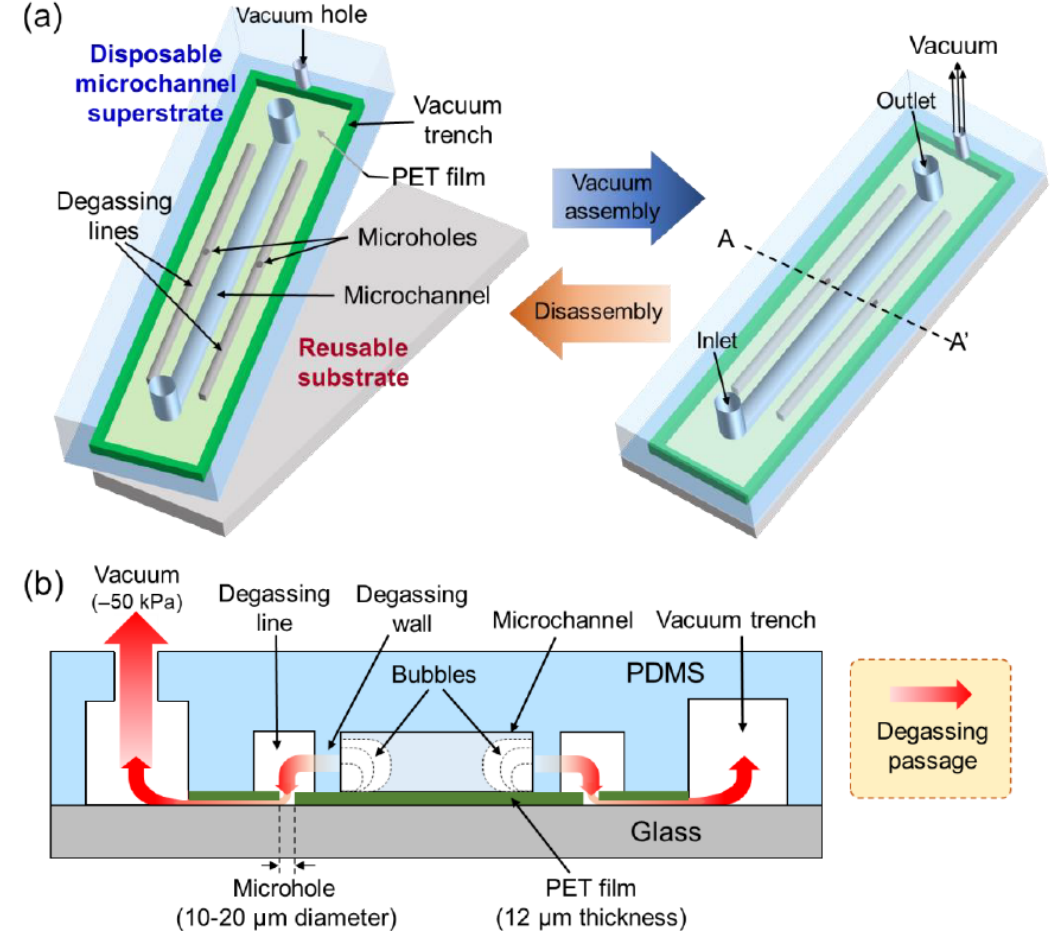
Figure 1. Working principle of the lateral degassing method. ( a ) Assembly and disassembly of the disposable microchannel superstrate and the reusable substrate by vacuum pressure. ( b ) Discharge of air bubbles.